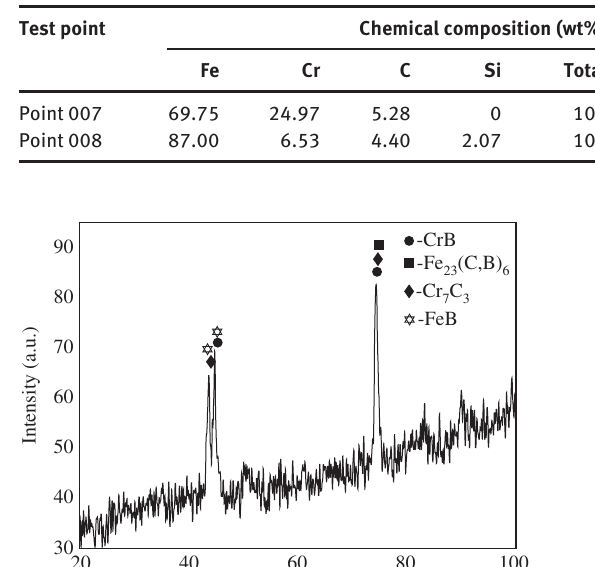
Table 4 EDS analysis results of cladding layer of test point.